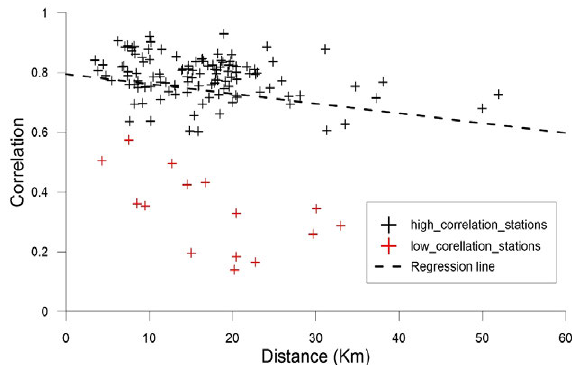
Fig. 4. Correlation-distance plot between weather stations with deleted station in cross red